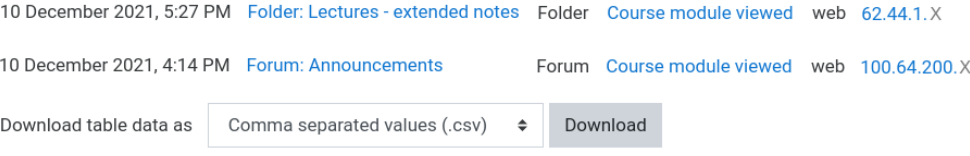
Figure 10. Export of students’ actions from Moodle. The figure is modified for presentation and privacy reasons.